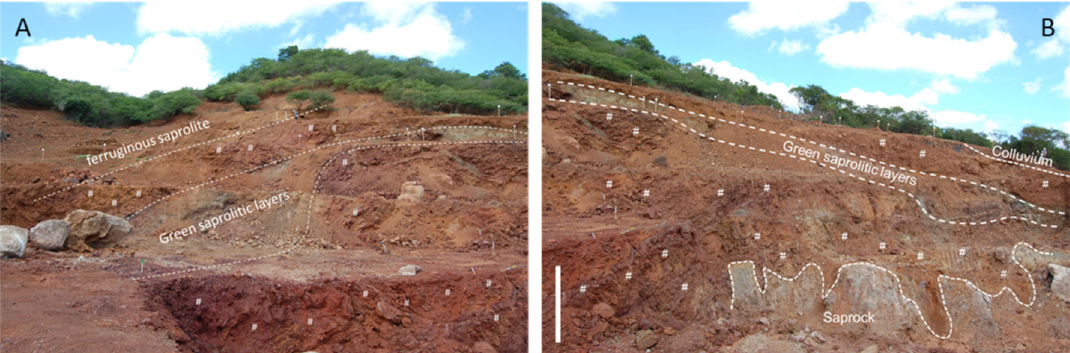
Figure 2. Profile of the Piau í deposit showing the rock units used during fieldwork (( A ) looking west; ( B ) looking southwest). Unit indicated with # is a silicified ferruginous saprolite (scale bar = 3